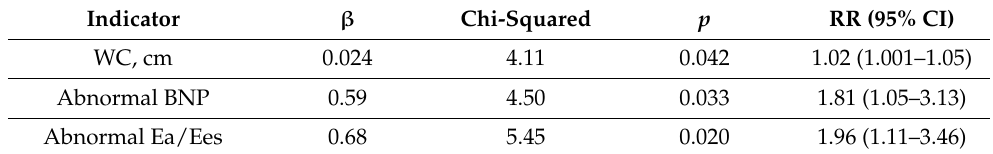
Table 4. A multivariate model for the development of ALVR in STEMI patients. Indicator β Chi-Squared p RR (95% CI) WC, cm Abnormal